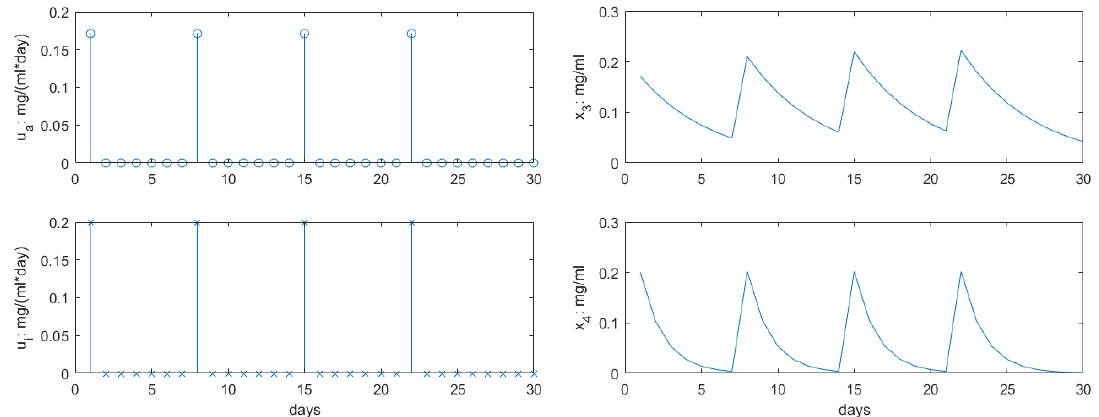
Figure 3. The dose rates and concentrations for the antiangiogenesis and immunotherapy drug profiles. These will remain fixed during the changes in radiotherapy